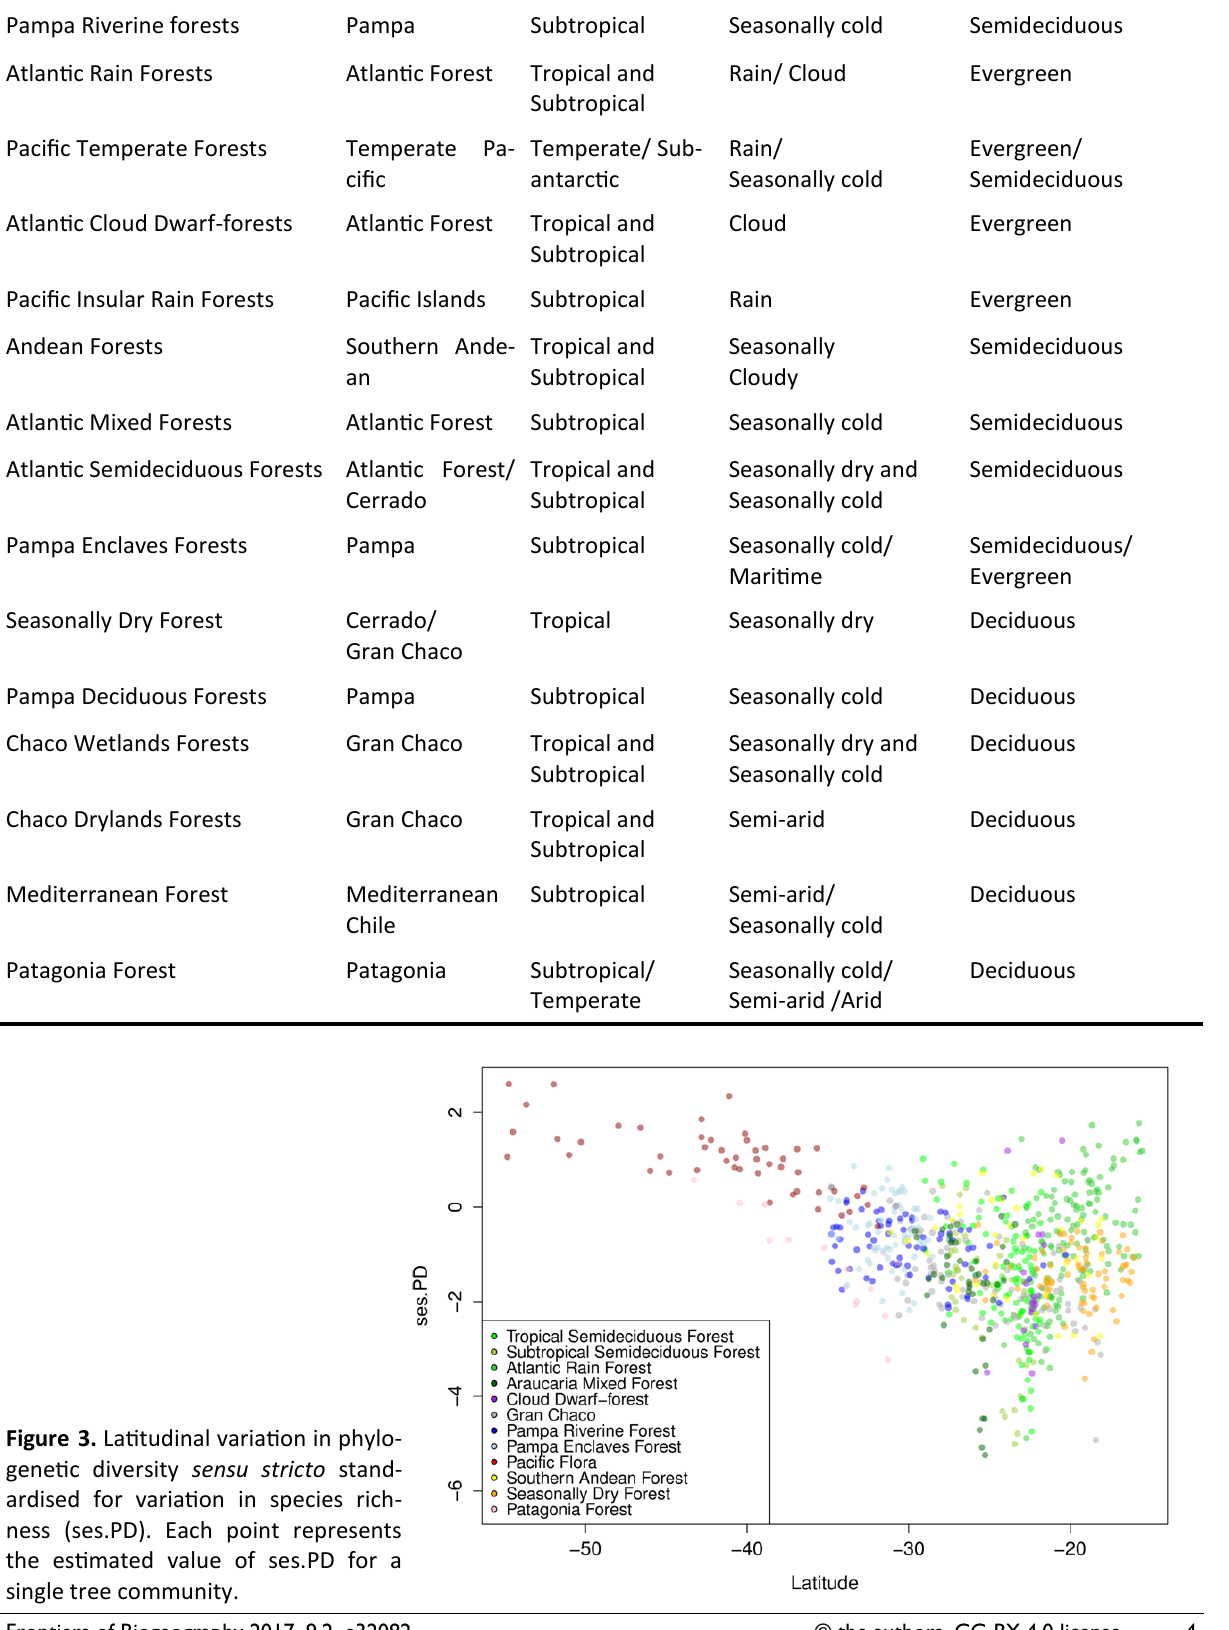
Table 1. Phytogeographic characteristics of the main vegetation types that occur in southern South America.